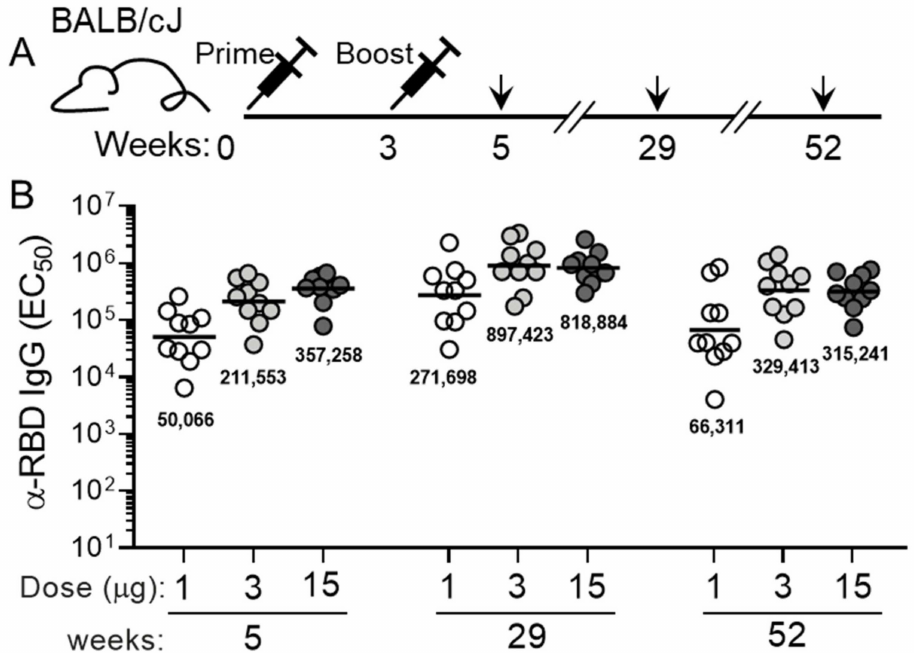
Figure 2. Dose-response and durability of anti-RBD serum IgG levels in mice vaccinated intramus- cularly with Alhydrogel-adjuvanted MT-001. ( A ) Immunization and bleeding schedule. Prime and secondary immunizations of the animals were at weeks 0 and 3, respectively; bleeds were performed on week 5, week 29, and week 52 to provide sera for analyses. Primary and secondary immunizations were with the same amount of MT-001 antigen per animal—1 µ g, 3 µ g, or 15 µ g—for each group of 10 mice. ( B ) Midpoint (EC 50 ) geometric mean anti-RBD IgG ELISA titers for each dosage group at each time point. GMTs are indicated numerically below each cluster of